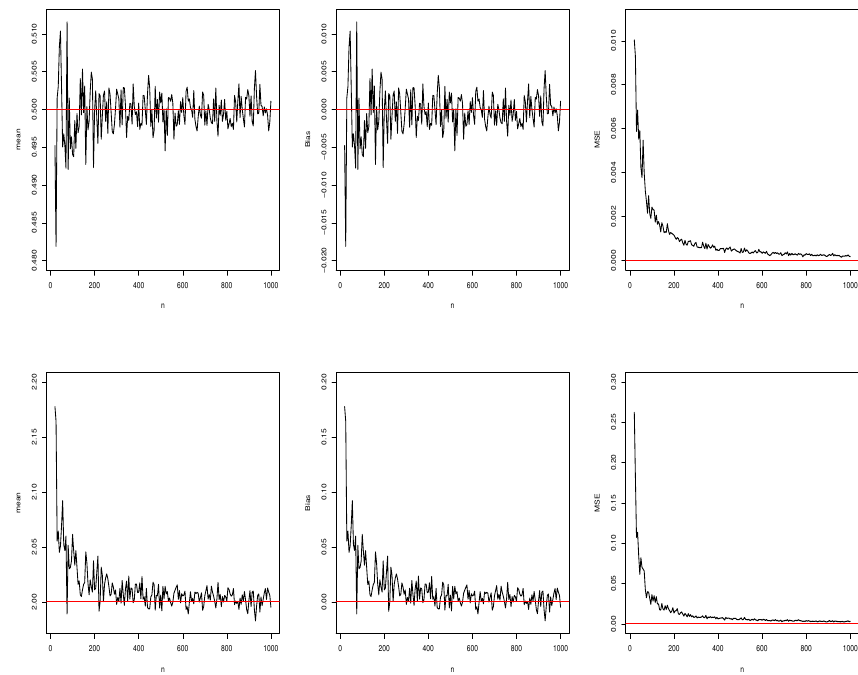
Figure 8. The results of the α ( top ) and β ( bottom ) parameters for the simulation-III